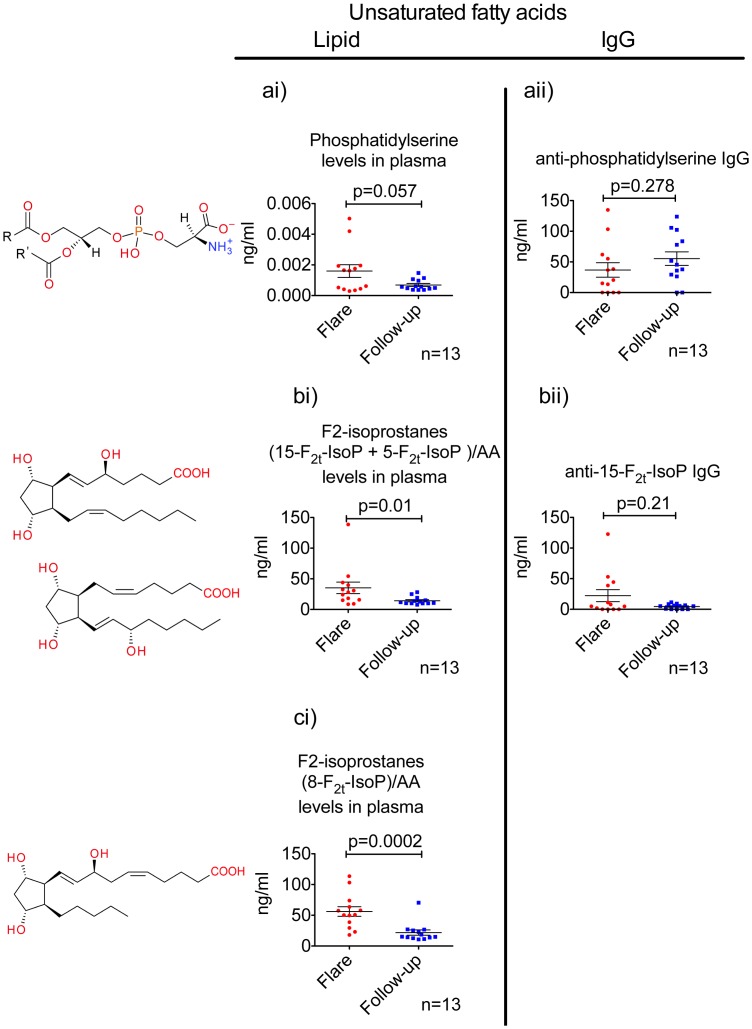
Levels of unsaturated fatty acids and anti-unsaturated fatty acids IgG in SLE patients’ plasma.
Figure 3ai and 3aii. Phosphatidylserine levels and anti-phosphatidylserine IgG levels in plasma. Figure 3bi and 3bii. Isoprostane (15-F2t-IsoP +5-F2t-IsoP) levels normalized against AA values and anti-15-F2t-IsoP IgG levels in plasma. Figure 3ci. Isoprostane (8-F2t-IsoP) levels normalized against AA values. p<0.05 value was considered as significant in Wilcoxon test.